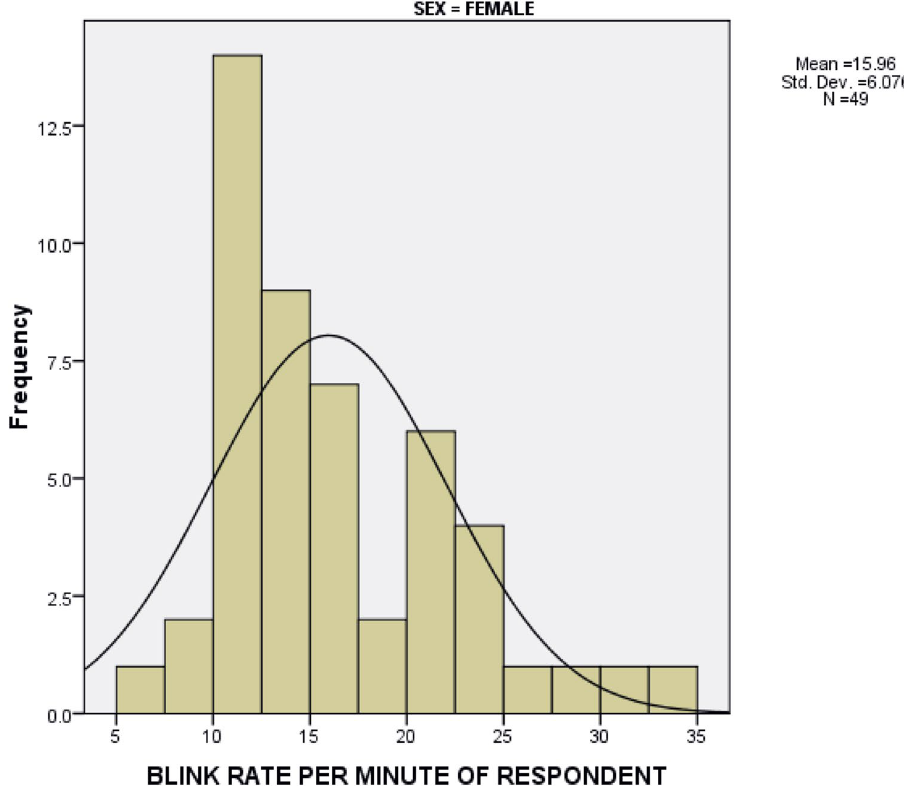
Figure 3. Distribution of blinking rate among